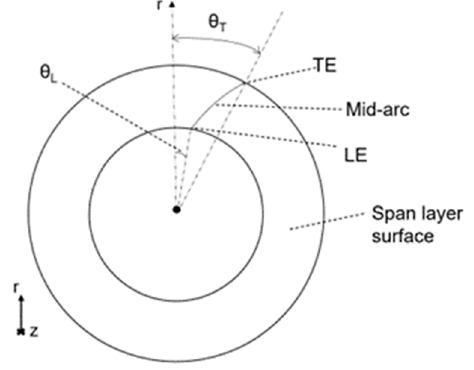
Figure 4. Curved Figure 4. Curved mid-arc. Table 2. Geometrical design parameters of the initial rotor.